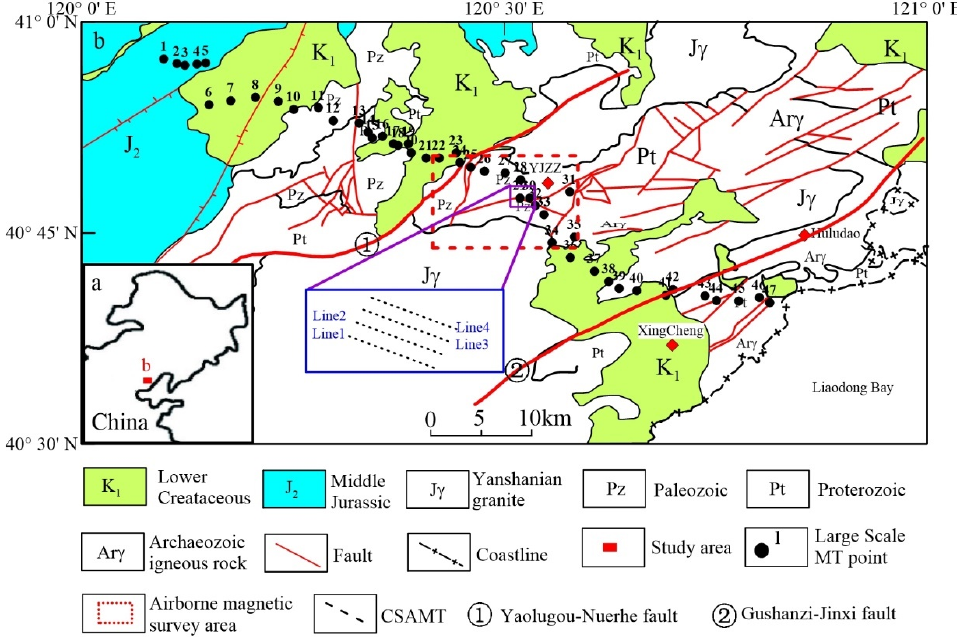
Figure 1. ( a ) Location of study area; ( b ) surface geological map around the YJZZ area with geophysical survey locations.